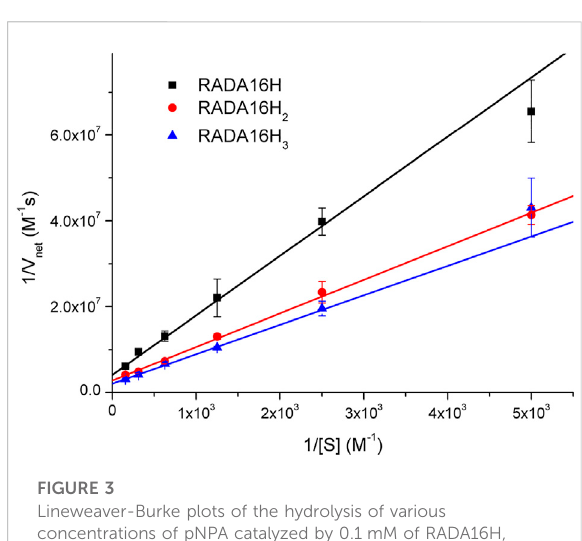
FIGURE 3 Lineweaver-Burke plots of the hydrolysis of various concentrations of pNPA catalyzed by 0.1 mM of RADA16H, RADA16H 2 and RADA16H 3 at 25 °